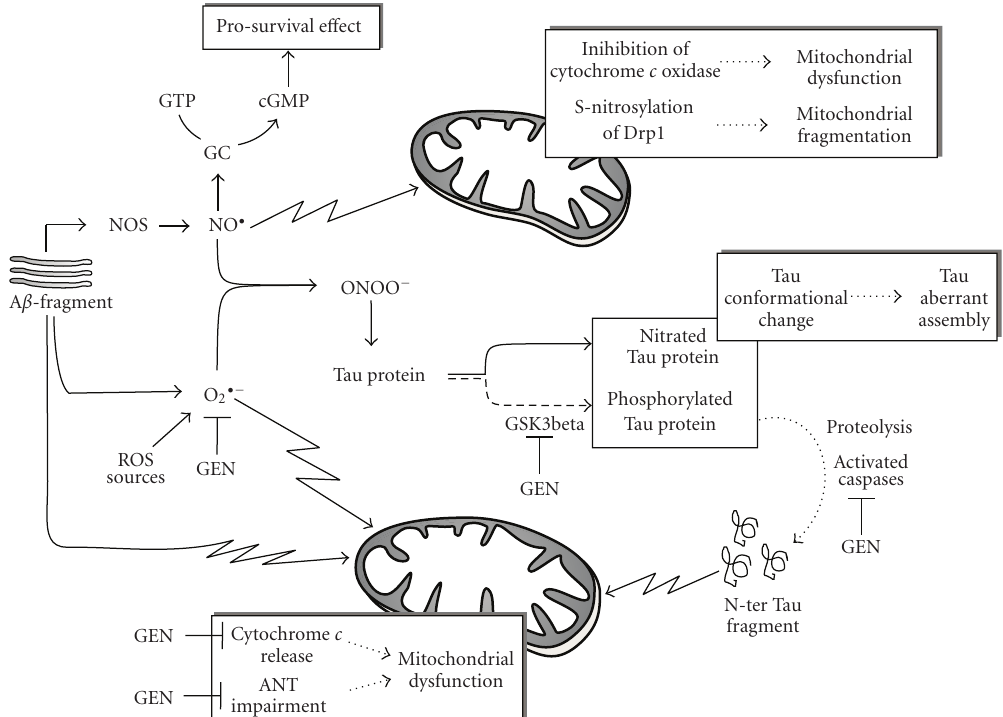
Figure 4: Schematic overview of the interplay between A β , Tau, oxidative/nitrosative stress, and mitochondria; see text for details. GC , guanylil cyclase; cGMP , cyclic GMP; NOS , nitric oxide synthase; O 2 •− , superoxide anion; ONOO − , peroxynitrite; ANT , adenine nucleotide translocator; GSK3beta, glycogen synthase kinase-3beta; GEN , Genistein.